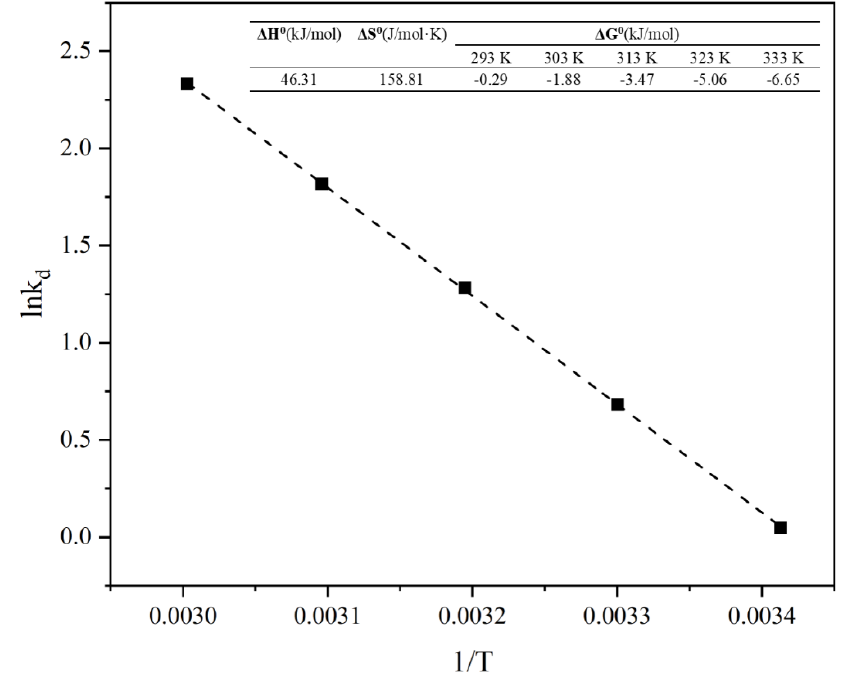
Figure 7. Adsorption